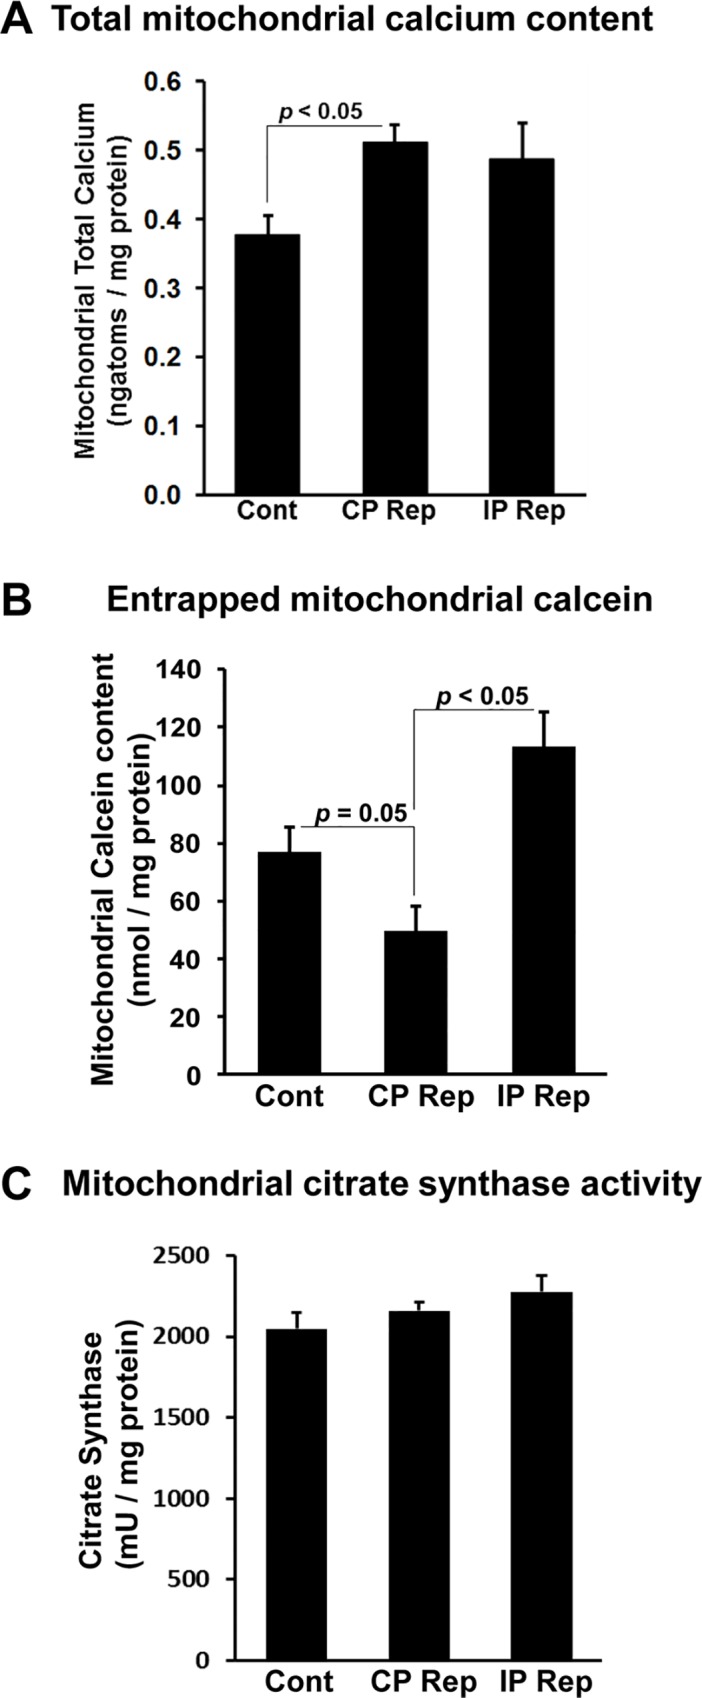
Measurement of total calcium content, entrapped calcein and citrate synthase activity in mitochondria isolated from control and IP hearts after ischemia / reperfusion.Mitochondria were isolated from normoxic control hearts (Cont) and both control (CP Rep) and IP (IP Rep) hearts subject to 30 min ischemia and 90 s reperfusion as described in S1 Fig. Data are given as means ± SEM (error bars) of 4 hearts in each group.